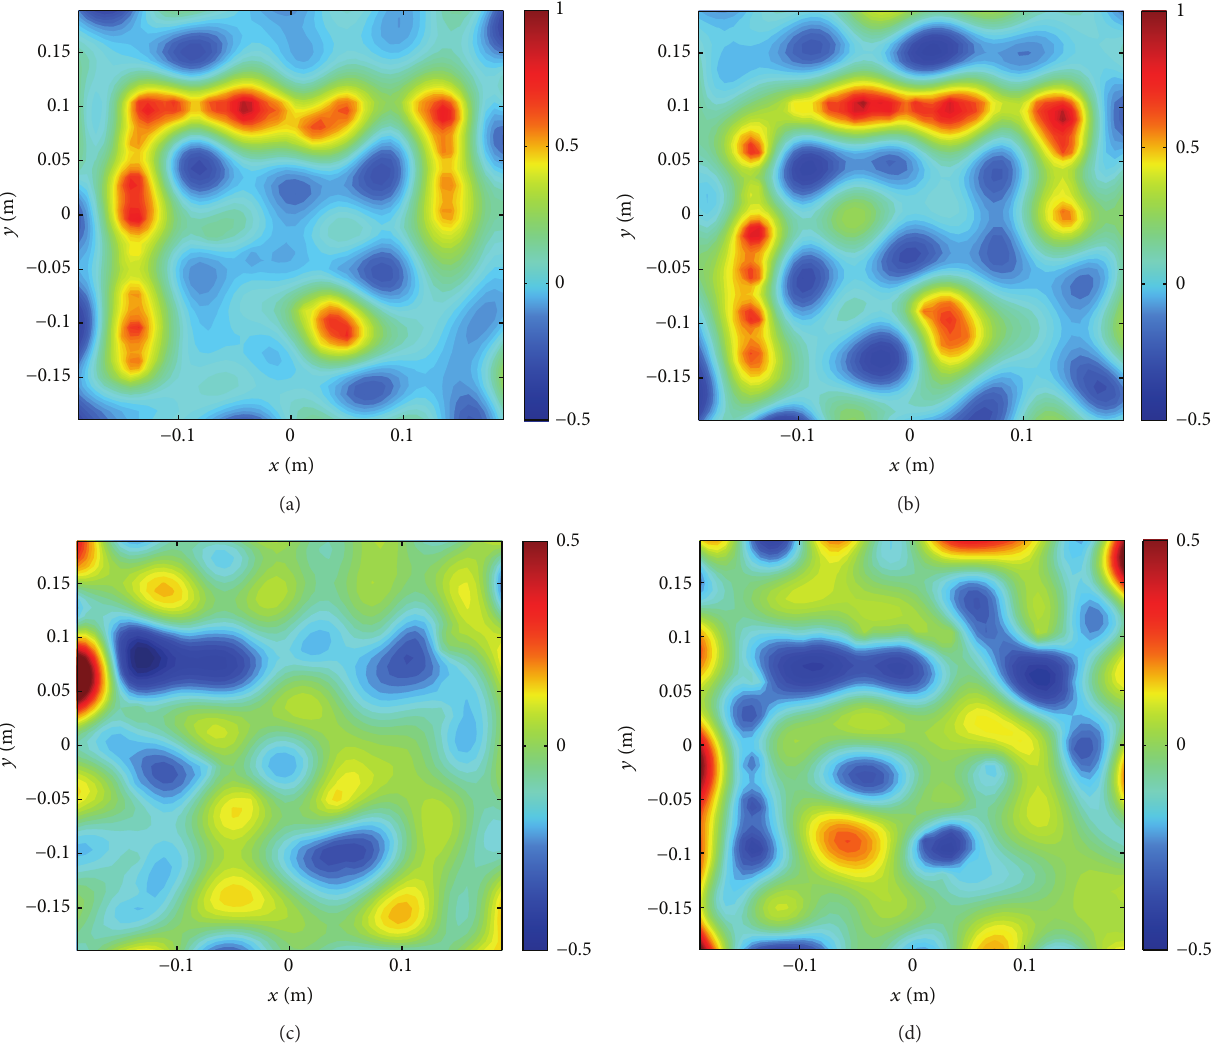
Figure 14: Example 2 with flipped scatterers: QLSM reconstructions in a triangular enclosure. ((a), (c)) Real and imaginary parts of retrieved profiles in measurement configuration A; err = 0.35. ((b), (d)) Real and imaginary parts of retrieved profiles in measurement configuration B; err = 0.45.